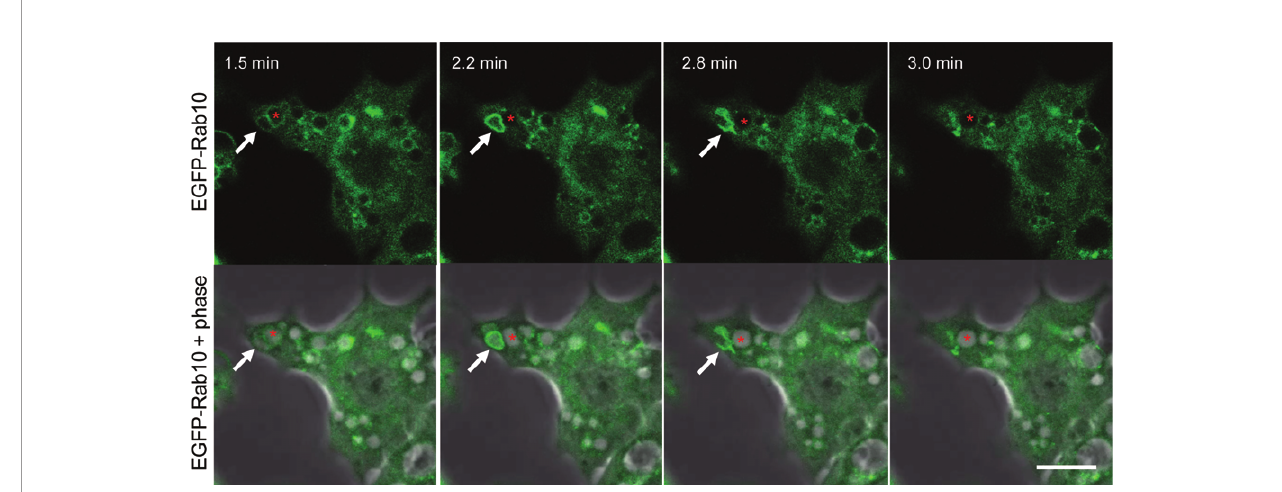
FIGURE 2 | Short-lived Rab10-positive premacropinosomal structures exist in RAW264 cells under near-physiological conditions. Confocal live-cell imaging of RAW 264 cells expressing EGFP-Rab10 stimulated with 10 nM phorbol myristate acetate (PMA). Elapsed times after the addition of PMA are shown in the frame. Arrows indicate a Rab10-positive premacropinosome which disappears within a few minutes. Asterisks indicate a Rab10-negative macropinosomal structure that remains as a phase-bright macropinosome. Scale bar = 10 m m. The corresponding movie is available in the Supplementary Material Movie 3